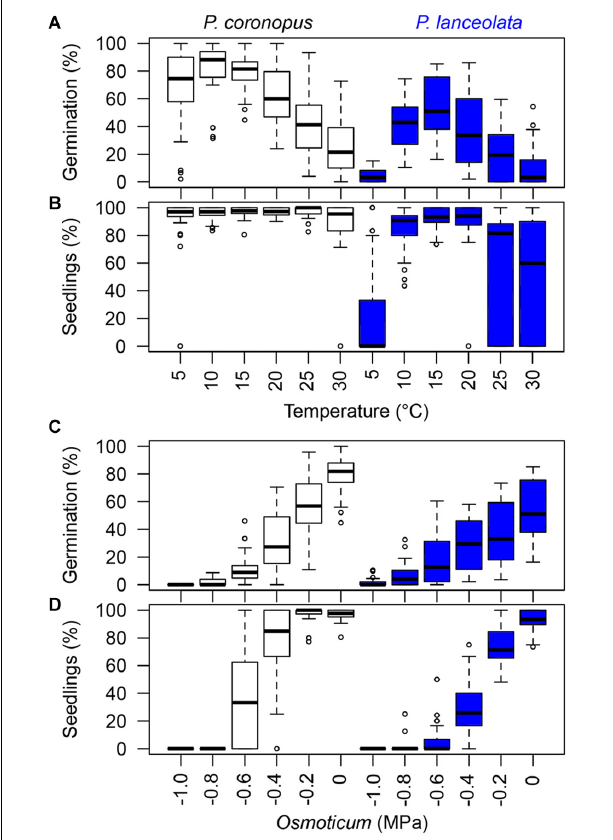
FIGURE 1 | Seed germination percentages calculated from the total viable sowed seeds and normal seedlings as percentage of all germinated seeds, expressing the relative conversion from seed germination to normal seedlings. The boxplots show the minimum, first quartile, median, third quartile, maximum, and the suspected outliers for the germination and seedlings in temperature conditions (A,B) and germination and normal seedlings in osmoticum (C,D) . The boxplot colors represent the different species with 10 accessions each: P. coronopus (white); P. lanceolata